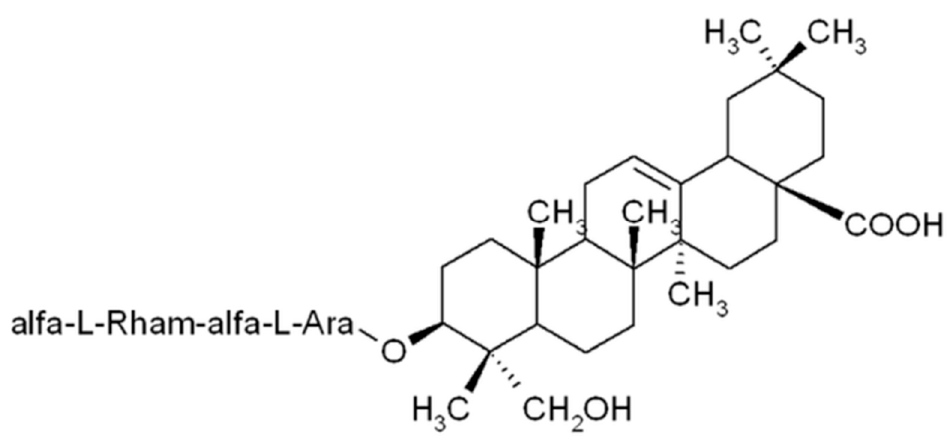
Figure 1. The structure of alpha-hederin ( α -HN) [1].